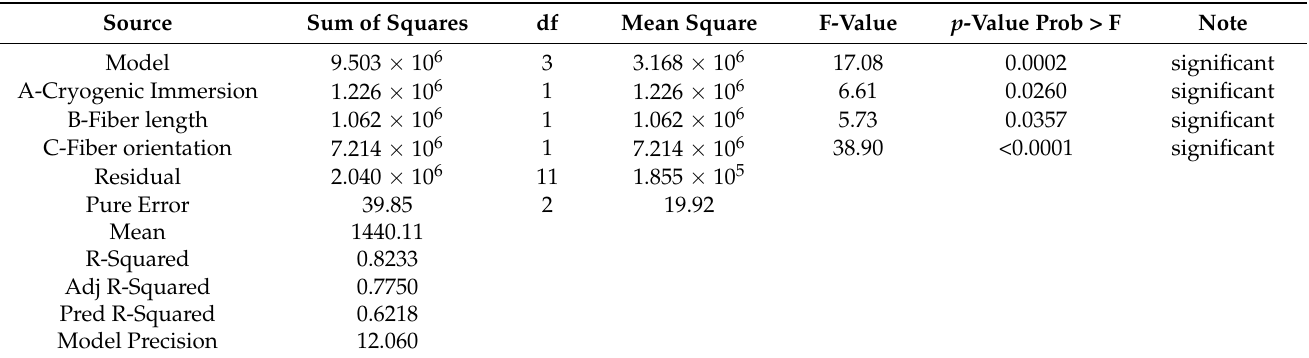
Table 7. ANOVA for flexural